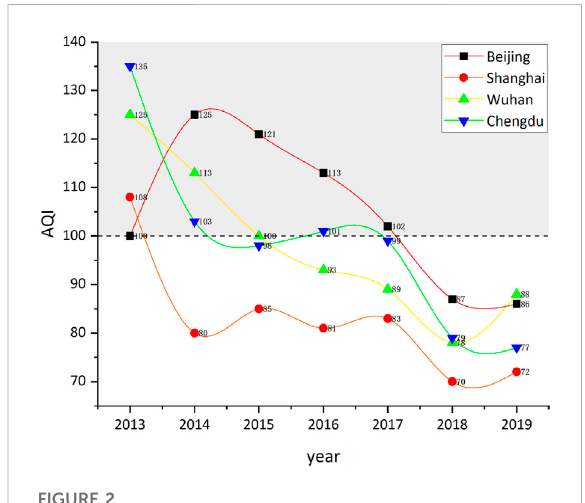
FIGURE 2 The changes in Chinese Air quality Index of Four typical cities from 2013 to